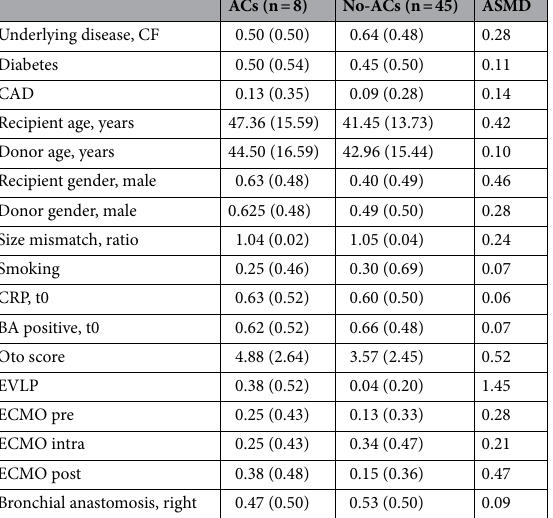
Table 1. Demographic and clinical characteristics of patients, stratified by groups (ACs = Airways complications; No-ACs = No airways complications), expressed as absolute standardize mean difference.